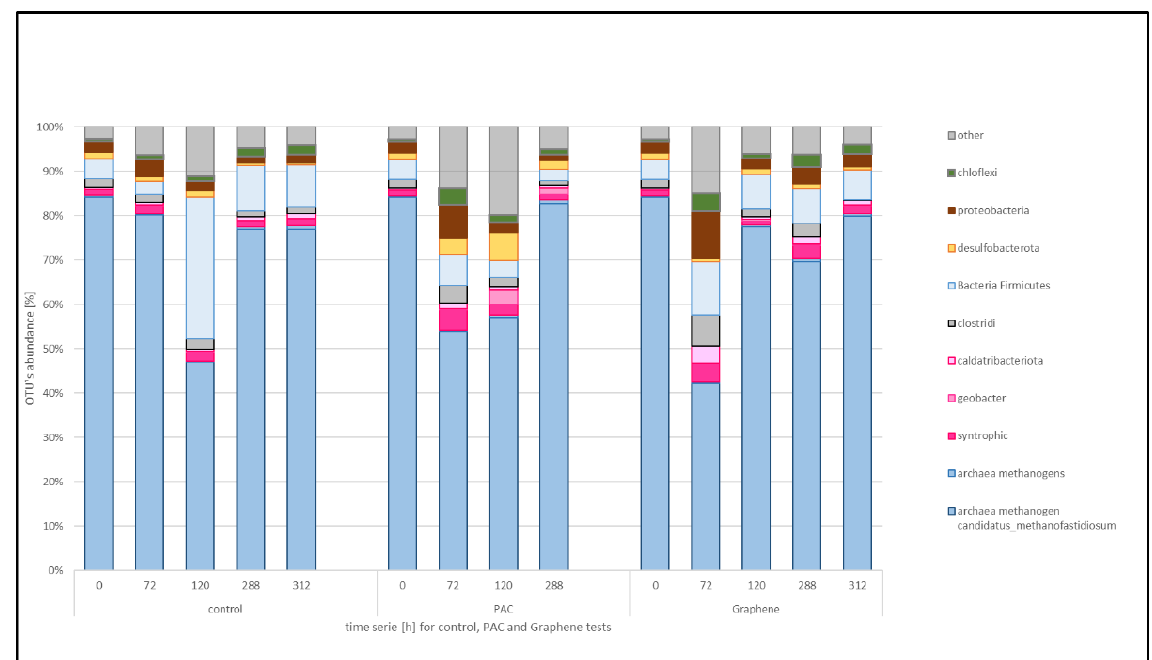
Figure 5. Structure of microbial communities in the different treatments and time expressed as func- tional relevant OTUs percentage. OTUs with an abundance lower than 0.05% are grouped together as “other”.